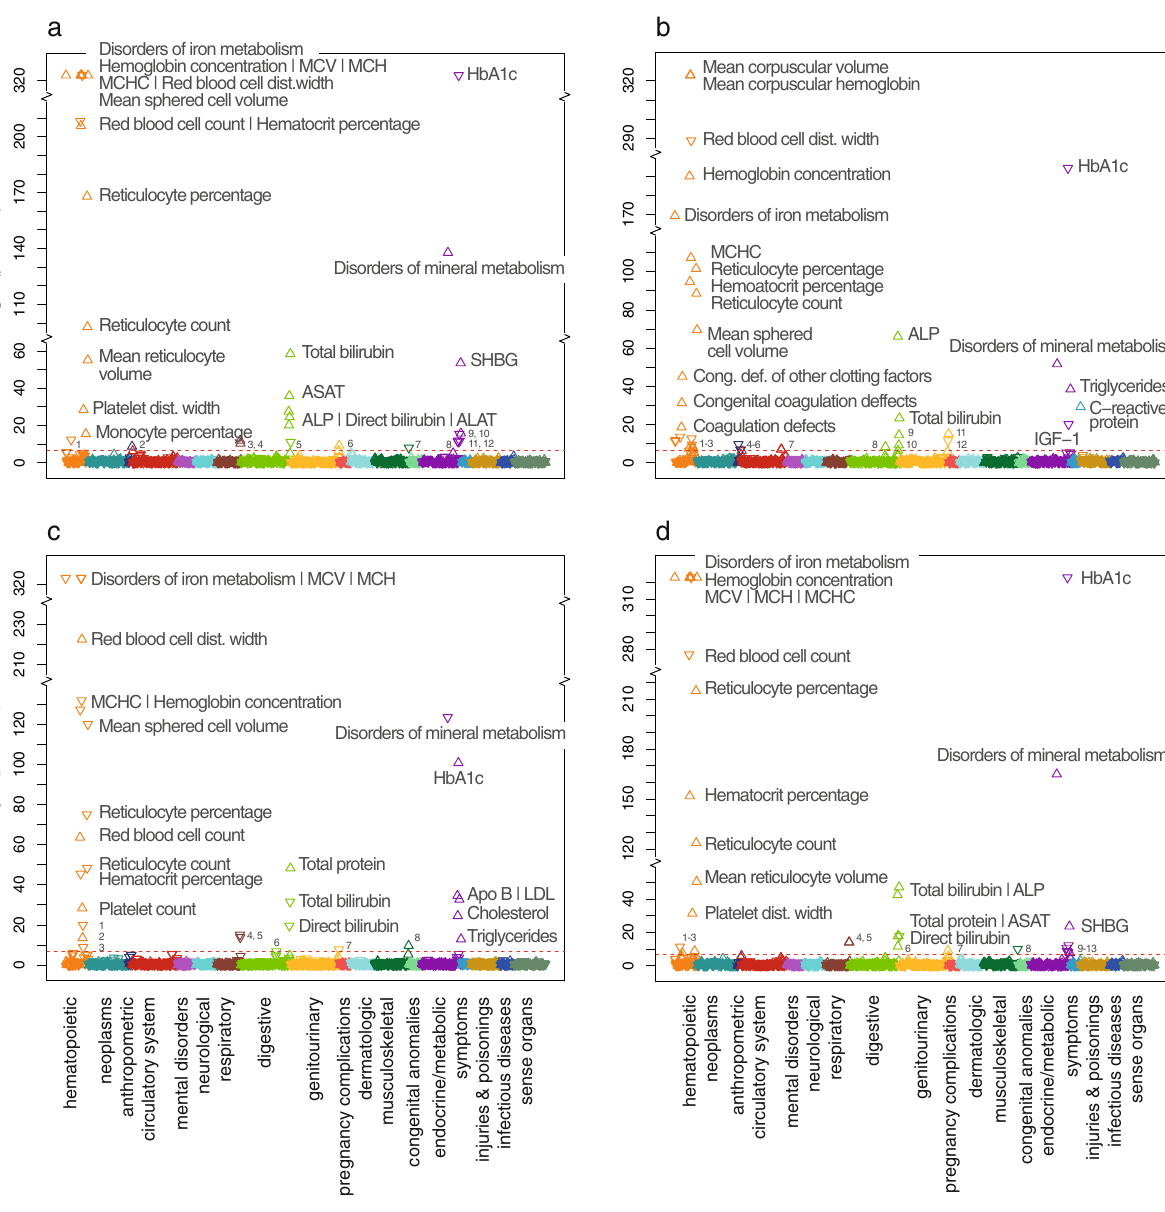
Fig. 1 Phenome-wide associations between GRSs for iron status biomarkers and 1473 phecodes, blood biomarkers, and continuous traits in the UK Biobank. Phenome-wide associations between the GRS for each biomarker (serum iron [ a ], serum ferritin [ b ], total iron-binding capacity [ c ], and transferrin saturation percentage [ d ]) and 1473 phecodes, blood biomarkers, and continuous traits in the UK Biobank. Triangles pointing upwards indicate a positive association between the phenotype and the GRS (where a higher GRS score represents higher level of the biomarker) and vice versa. Associations with p -values < 10 − 324 are plotted at 10 − 324 . The Bonferroni corrected p -value cut-off (2.3 × 10 − 7 ) is given as a red dotted line. Biological domains are indicated by color; for the signi fi cant associations, these are: hematopoietic (orange), anthropometric (dark blue), circulatory system (red), respiratory (brown), digestive (light green), genitourinary (yellow), musculoskeletal (dark green), endocrine/metabolic (magenta), symptoms (light blue). Abbreviations: MCV mean corpuscular volume, MCH mean corpuscular hemoglobin, MCHC mean corpuscular hemoglobin concentration, dist. distribution, Cong. def. congenital de fi ciencies, HbA1c glycated hemoglobin, SHBG sex hormone-binding globulin, LDL low-density lipoproteins, Apo B apolipoprotein B, IGF-1 insulin-like growth factor 1, FEV1 forced expiratory volume (1 s), FVC forced vital capacity, ALP alkaline phosphatase, ASAT aspartate aminotransferase, ALAT alanine aminotransferase, GGT gamma-glutamyl transferase. a : 1 Other anemias, 2 Impedance, 3 FEV1, 4 FVC, 5 Total protein, 6 Cystatin C, 7 Phosphate, 8 Apo B, 9 Testosterone, 10 IGF-1, 11 Cholesterol, 12 LDL. b : 1 Anemias (iron de fi ciency and other anemias), 2 Platelet indices (platelet count, platelet crit, platelet dist. width), 3 White blood cell counts (lymphocytes, leukocytes, monocytes), 4 Seated height, 5 Water mass, 6 Fat-free mass, 7 Phlebitis and thrombophlebitis, 8 Non-alcoholic liver disease, 9 Gamma-glutamyl Transferase, 10 Direct bilirubin, 11 Urate, 12 Creatinine. c : 1 Mean platelet volume, 2 Platelet crit, 3 Platelet dist. width., 4 FEV1, 5 FVC, 6 Liver cirrhosis, 7 Cystatin C, 8 Phosphate. d : 1 Other anemias, 2 Monocyte percentage,